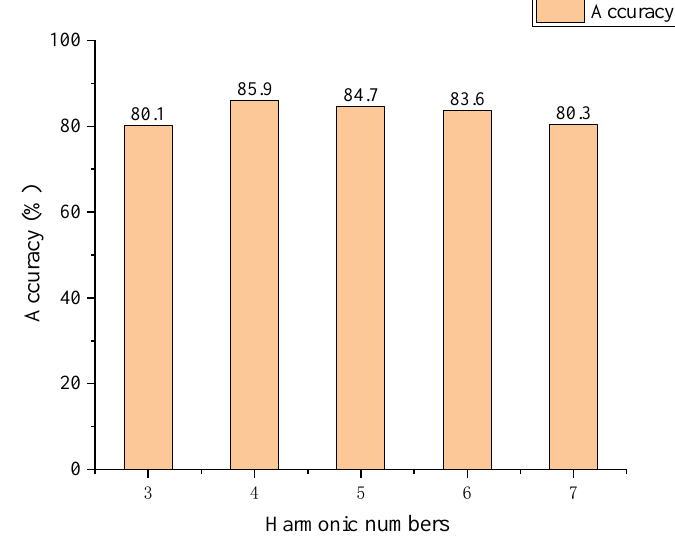
Figure 8. The accuracy of different harmonic